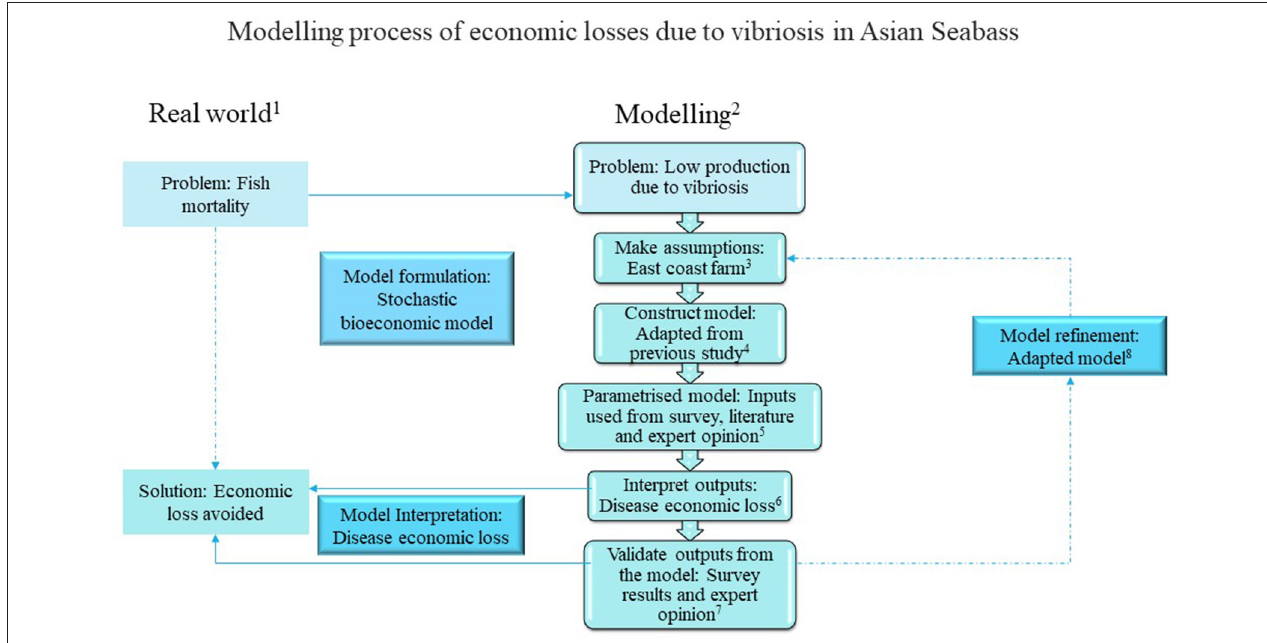
FIGURE 1 | A framework for the estimation of economic losses due to vibriosis in Asian seabass in floating net-cages on the east coast of Peninsular Malaysia. 1 In the real world, fish mortality is one of the major problems experienced by fish farms, which causes economic losses. A stochastic bioeconomic model is formulated to simulate this issue. 2 Bioeconomic modeling is used to simulate the problem of low production due to vibriosis: first, we state the relevant assumptions; second, we construct the model in Microsoft Excel using @Risk add-on; third, we select the suitable parameters of the model using biological and economic inputs from existing literature, survey results, and expert opinion; fourth, we interpret and validate the outputs to modify the model where necessary. 3 Following our assumptions, the bioeconomic model considers small-scale farm management on the east coast of Peninsular Malaysia; we conduct a survey that may help in model formulation. 4 We adapt the bioeconomic model from that of a previous study based on Asian seabass grow-out in cage farms on the west coast of Peninsular Malaysia. Details of the modeling of economic losses are shown in Figure 2 and Supplementary Figure 1 . 5 We obtain biological and economic inputs by conducting farm surveys, analyzing the prevalence of vibriosis from fish sampling, existing literature, and expert opinion (see Tables 1–5 ). 6 We interpret the model output in terms of economic losses from vibriosis (see section Analysis of the economic loss due to vibriosis using a stochastic model). 7 Survey results (see section Survey results) and expert opinion are used to validate the model output. 8 We modify the model by adapting small-scale farm management on the east coast of Peninsular Malaysia. This model includes the risk of Vibrio spp. infection from hatcheries and grow-out cage culture, assuming that the diagnosis or treatment for infected Asian seabass are not viable (assumption in the model refers to the inputs used in Tables 1–5